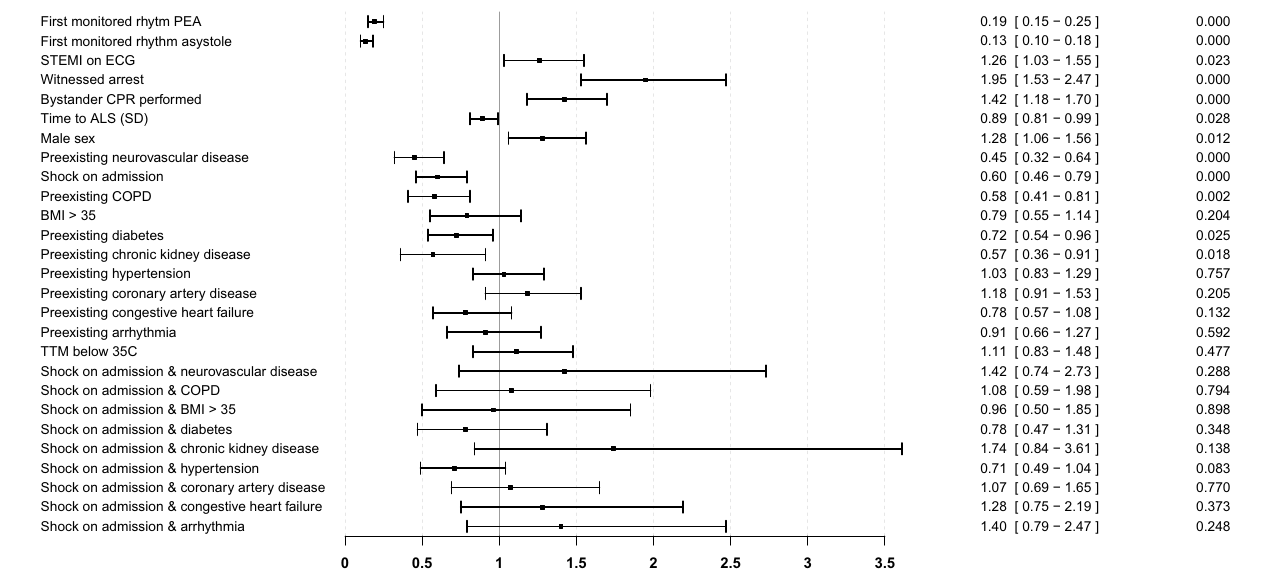
Figure 2. Association with good neurological outcome at hospital discharge. Forest plot illustrating the odds ratios for Cerebral Performance Category 1–2, in a multivariate generalized additive methods model. Analysis was performed in the full cohort, n = 4004. The reference category for first monitored rhythm is shockable rhythm (Ventricular fibrillation or ventricular tachycardia). Time to ALS time to ALS has been square root transformed scaled to standard deviations and centered. Interaction between circulatory shock and preexisting comorbidities are included in model. Point estimates are presented as odds ratios (OR) with 95% confidence intervals. Time to return of spontaneous circulation and age are included in model but not presented due to nonlinearity. PEA Pulseless electrical activity; STEMI ST-Elevation myocardial infarction; ECG Electrocardiogram; CPR Cardiopulmonary resuscitation; SD Standard deviation; COPD Chronic pulmonary obstructive disease; BMI Body mass index; TTM Targeted temperature